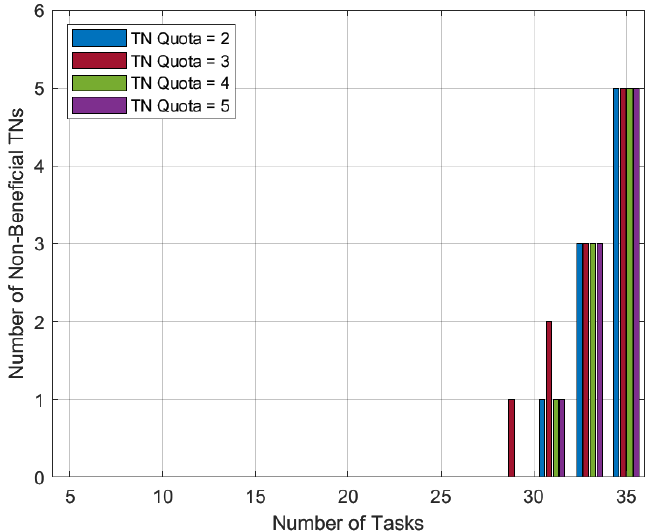
Figure 8. Non-beneficial TN tasks with varying quotas of TN